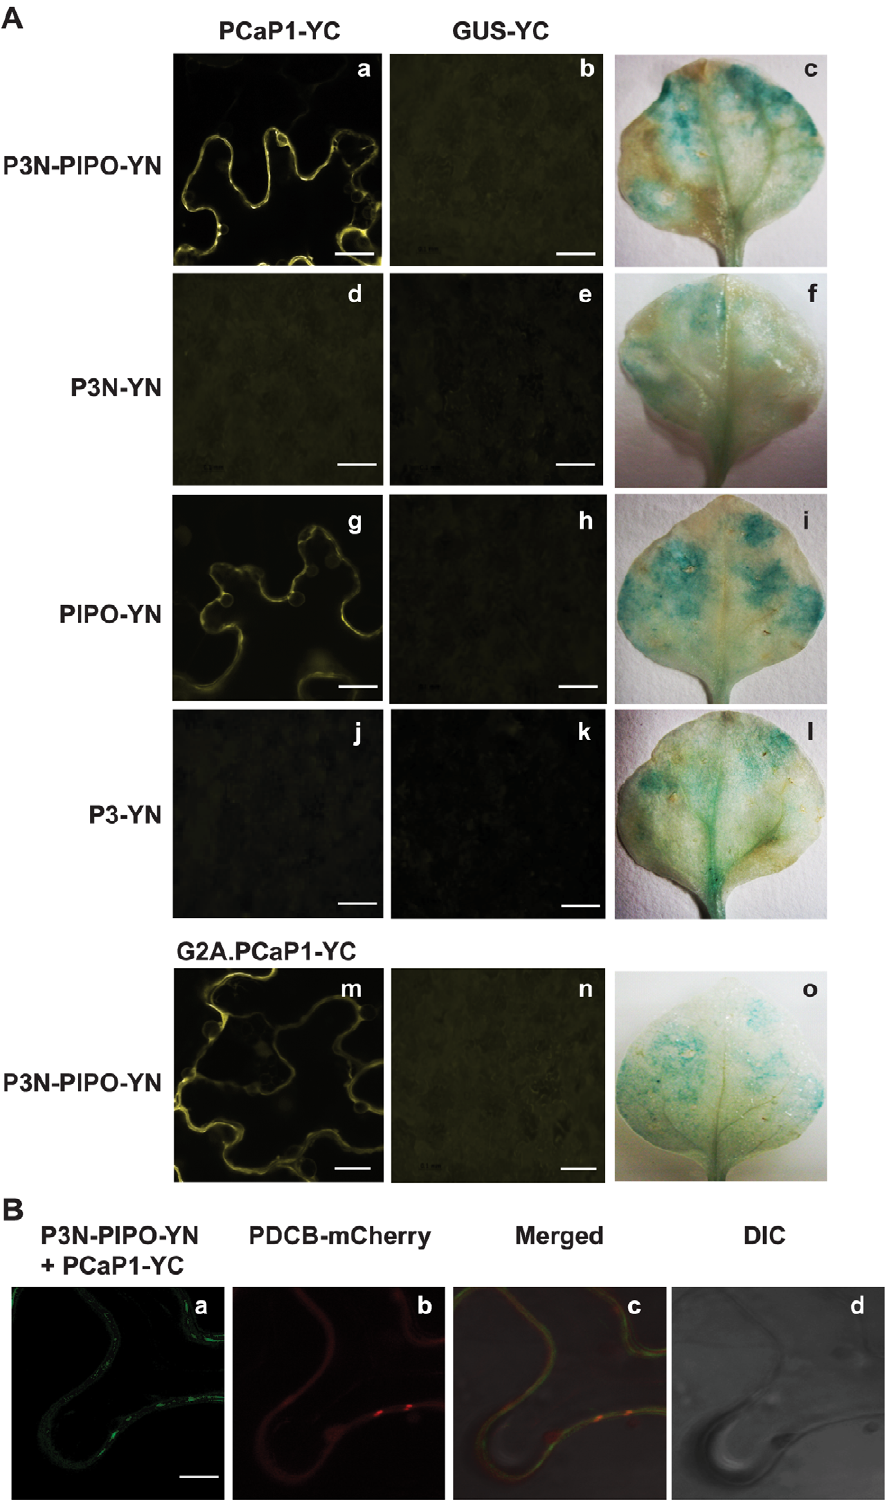
Figure 5. Bimolecular fluorescence complementation assay of P3N-PIPO, P3N, PIPO and P3 with wild-type and mutant PCaP1 in N. benthamiana . (A) Interactions of P3N-PIPO-YN, P3N-YN, PIPO-YN or P3-YN with PCaP1-YC, or P3N-PIPO-YN with PCaP1 containing a G to A amino acid substation at position two (G2A.PCaP1-YC) were analyzed at about 38 h post agroinfiltration (hpa) (panels a, d, g, j and m). P3N-PIPO-YN, P3N-YN, PIPO-YN or P3-YN interaction with GUS-YC are in panels b, e, h, k and n. Expression of GUS-YC was confirmed in all pair-wise interactions by histochemical staining (panels c, f, i, l and o). YN, N-terminal half of citrine; YC, C-terminal half of citrine; scale bar=25 m m. (B) Co-localization of P3N- PIPO-YN, PCaP1-YC and PDCB1-mCherry in plasmodesmata (38 hpa). Interaction of P3N-PIPO-YN and PCaP1-YC (color changed digitally to green